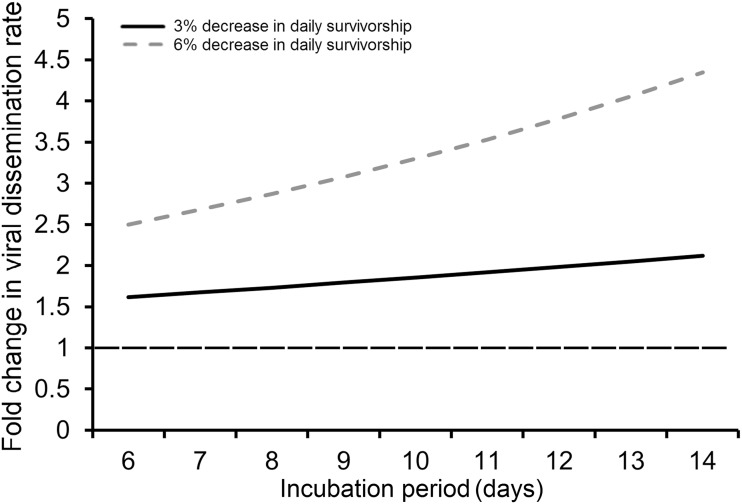
Change in viral dissemination rate necessary to compensate for decrease in daily survivorship rate.The figure above displays the change in viral dissemination rate necessary to compensate for a reduction in the daily survivorship rate by the specified amount from an estimated 90% survival rate.